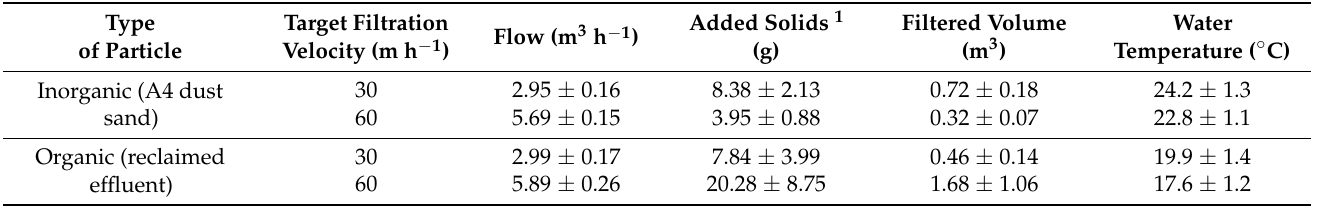
Table 2. Average ± standard deviation of mass of added solids, filtered volume and water temper- ature during the different experiments (N = 4).